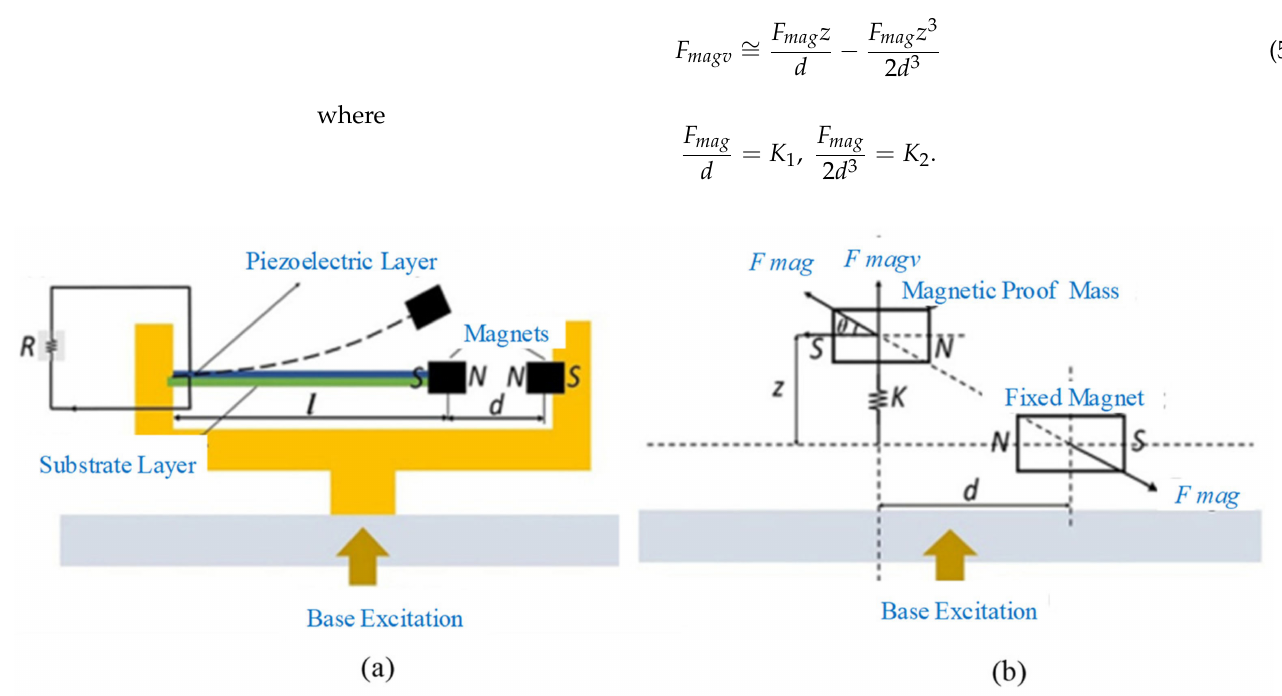
Figure 5. ( a ) Schematic of piezoelectric cantilever beam with magnetic proof mass (reproduced with permission from [136]; published by Wiley-VCH Verlag GmbH & Co. KGaA, Weinheim, 2015. ( b ) Free-body diagram of magnets (reproduced with permission from [136]; published by Wiley-VCH Verlag GmbH & Co. KGaA, Weinheim,